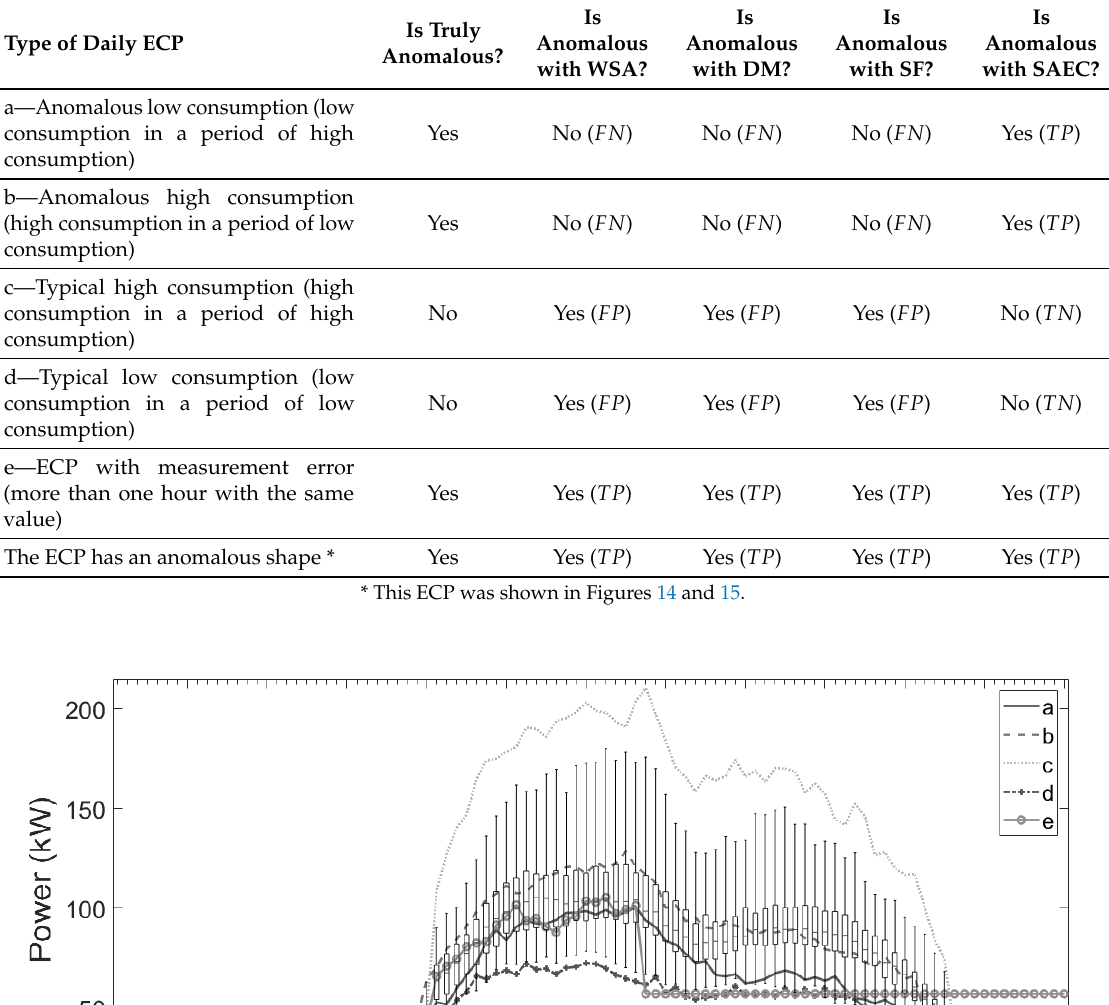
Table 5. Detection of anomalies for different seasonality analysis methods.